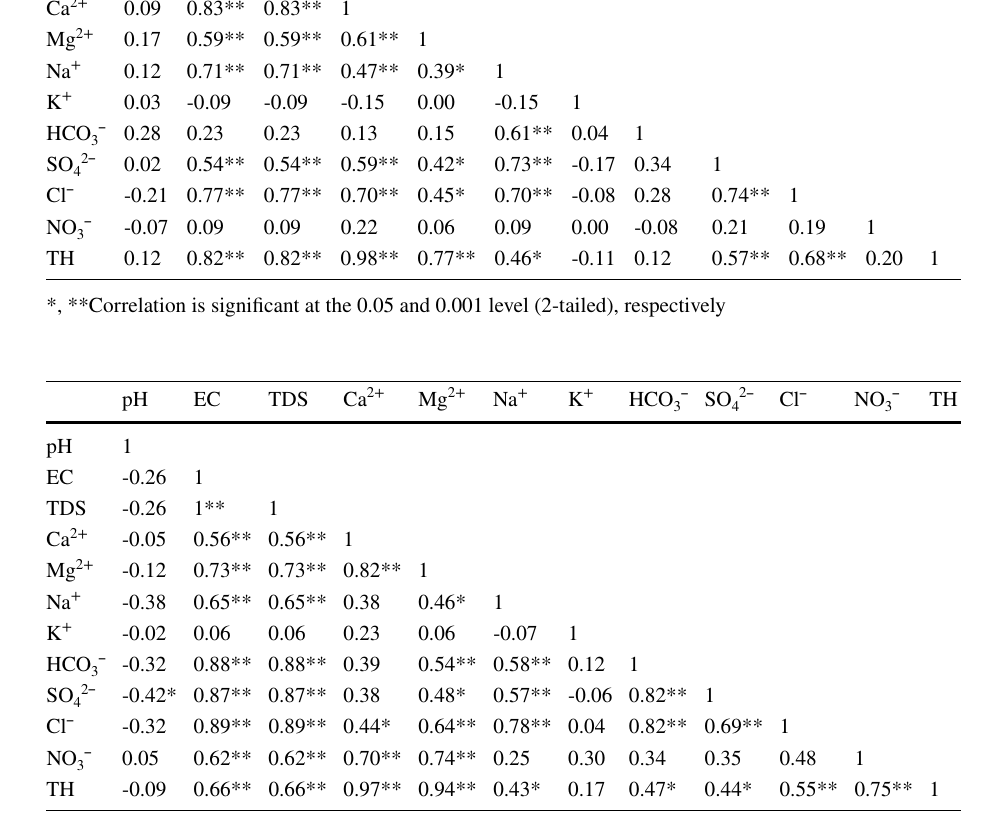
Table 6 Represents the correlation matrix results (Pearson) of physicochemical parameters in the studied deep aquifer water samples